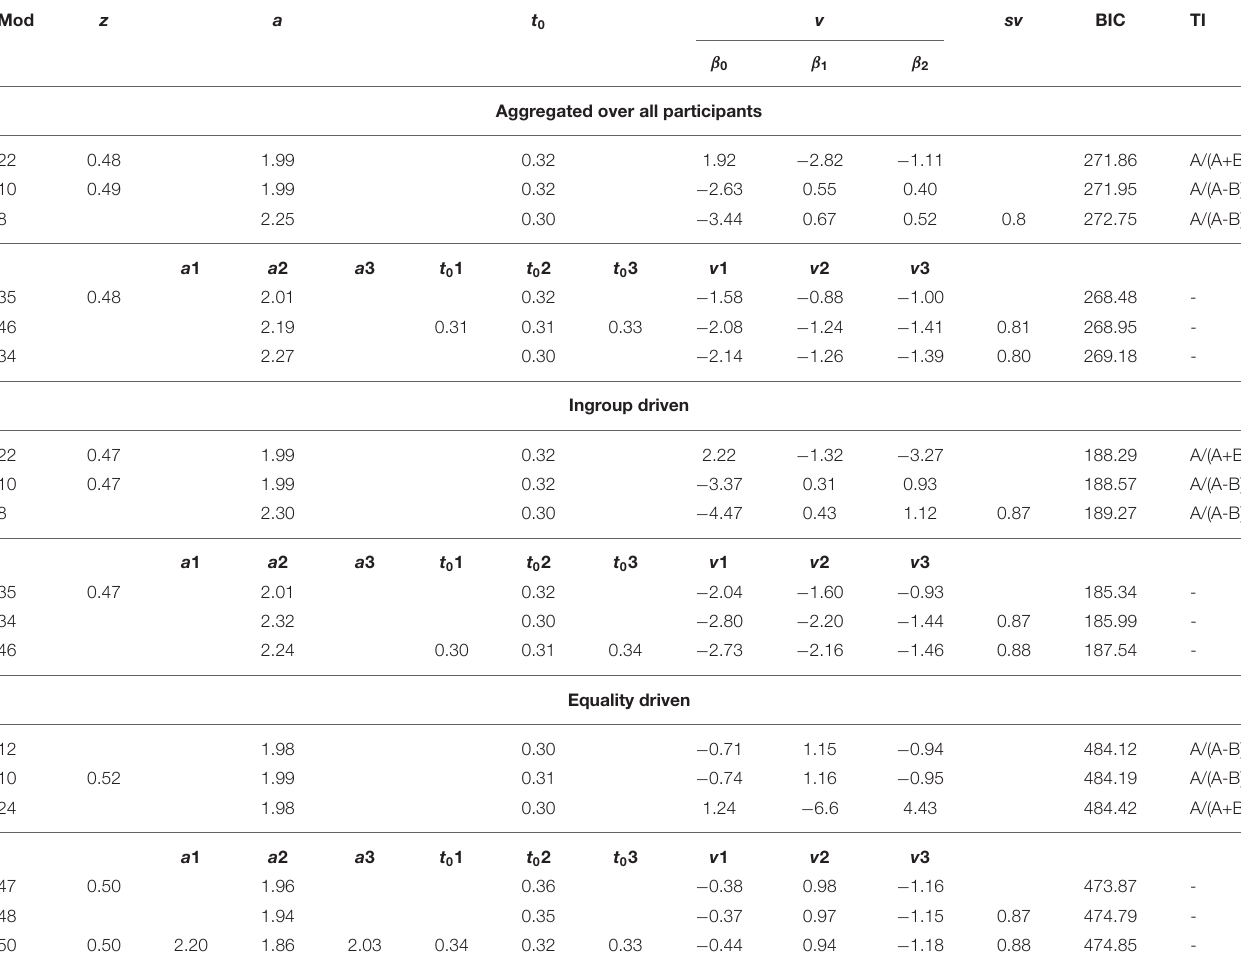
TABLE 3 | Mean model results of three best-fitting models for each model group and sample ( all participants vs. ingroup driven vs. equality driven ); TI, trial information used to inform β 1 and β 2 ; z is the relative bias; an empty cell in z or sv means, that the parameter is fixed to 0.5 and 0, respectively; an empty cell for a , or t 0 means, that this parameter was fixed for all three stimuli types—otherwise the parameter was allowed to vary between the stimuli